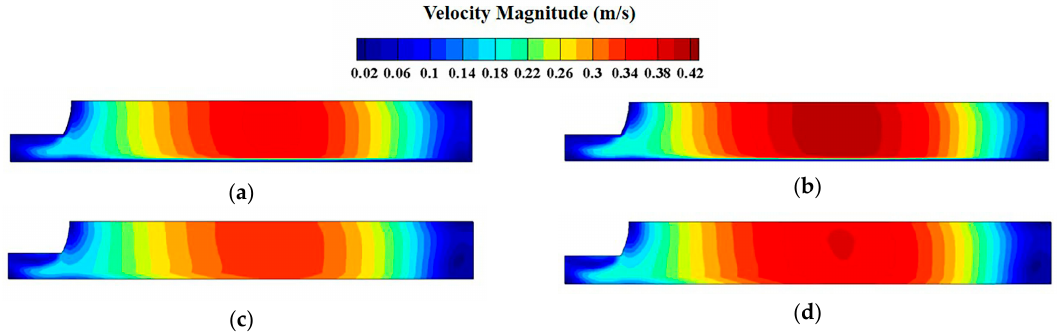
Figure 6. Contour of velocity magnitude at free-surface: ( a ) casting speed 1.6 m / min, submerged depth 70 mm; ( b ) casting speed 1.8 m / min, submerged depth 70 mm; ( c ) casting speed 1.6 m / min, submerged depth 90 mm; ( d ) casting speed 1.8 m / min, submerged depth 90 mm.